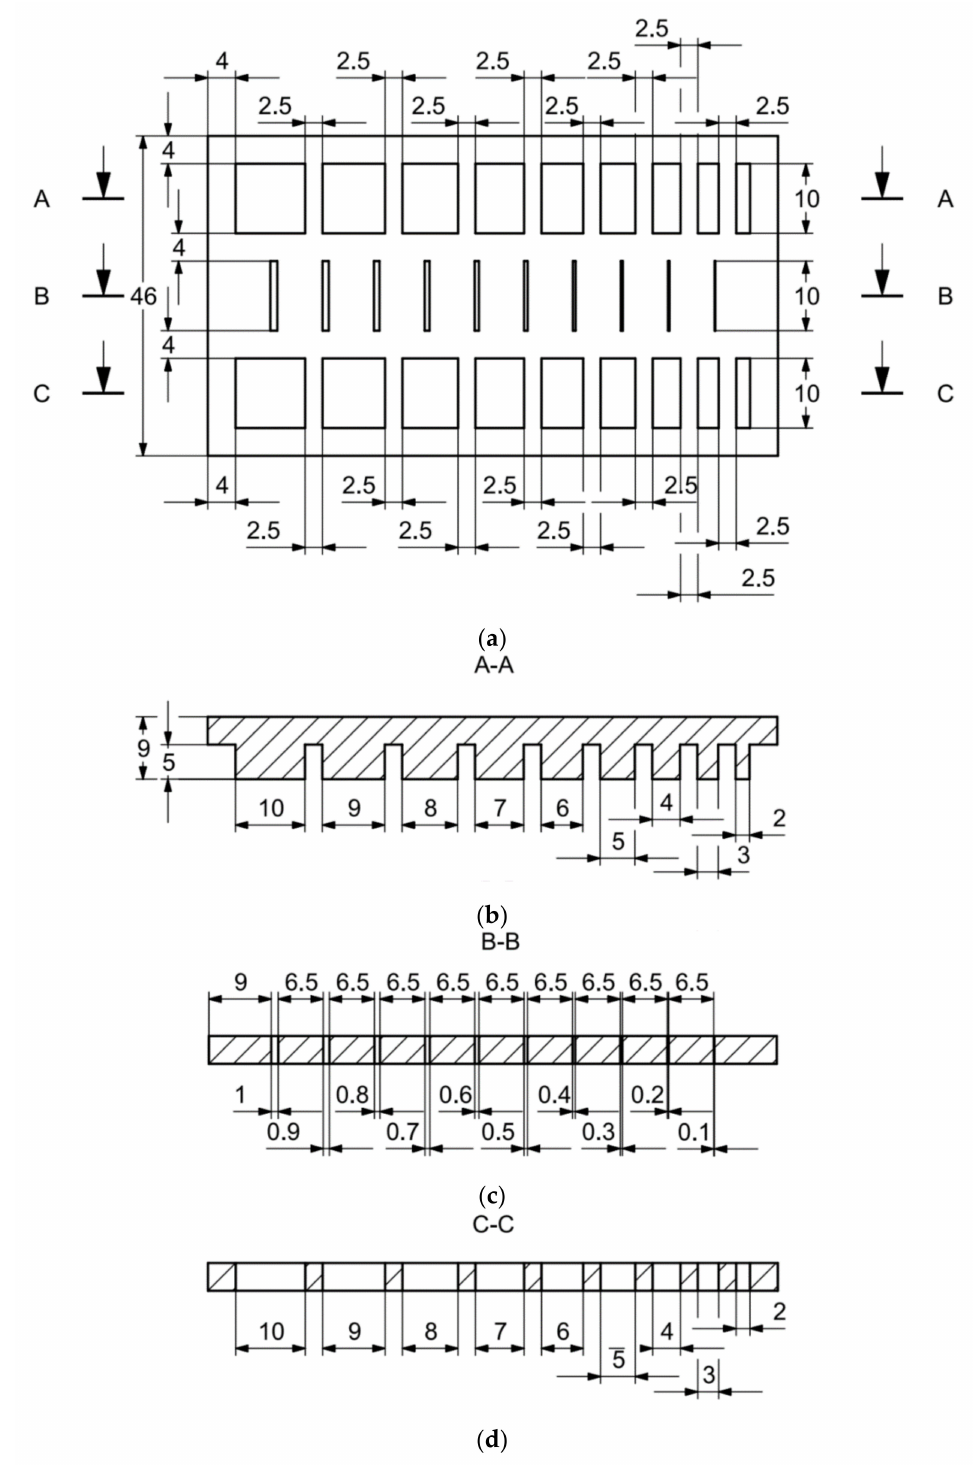
Figure 8. ( a ) The main view of the illustrative drawing of samples covered by the research is marked as MB3. ( b ) The A-A cross-section of solids 10–2 mm based on Figure 8a of the main view of an illustrative drawing of samples covered by the research is marked as MB3. ( c ) The B-B cross-section of cuboidal holes 1–0.1 mm based on Figure 8a of the main view of an illustrative drawing of samples covered by the research is marked as MB3. ( d ) The C-C cross-section of cuboidal holes 10–2 mm based on Figure 8a of the main view of an illustrative drawing of samples covered by the research is marked as